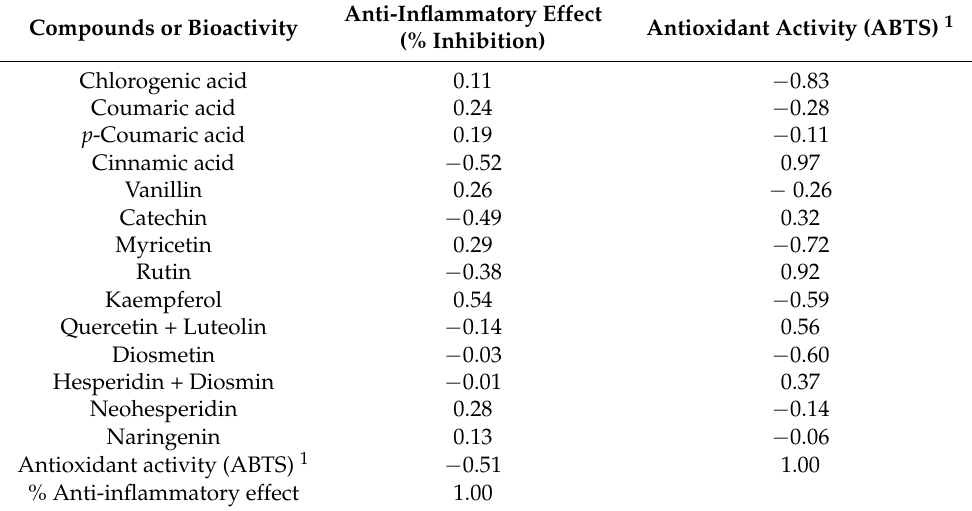
Table 3. Correlation matrix (Pearson’s correlation coefficients) for the anti-inflammatory effect, an- tioxidant activity, and polyphenol content of C. chinense by-product extracts obtained by maceration. Anti-Inflammatory Effect Compounds or Bioactivity Antioxidant Activity (ABTS) 1 (% Inhibition) Chlorogenic